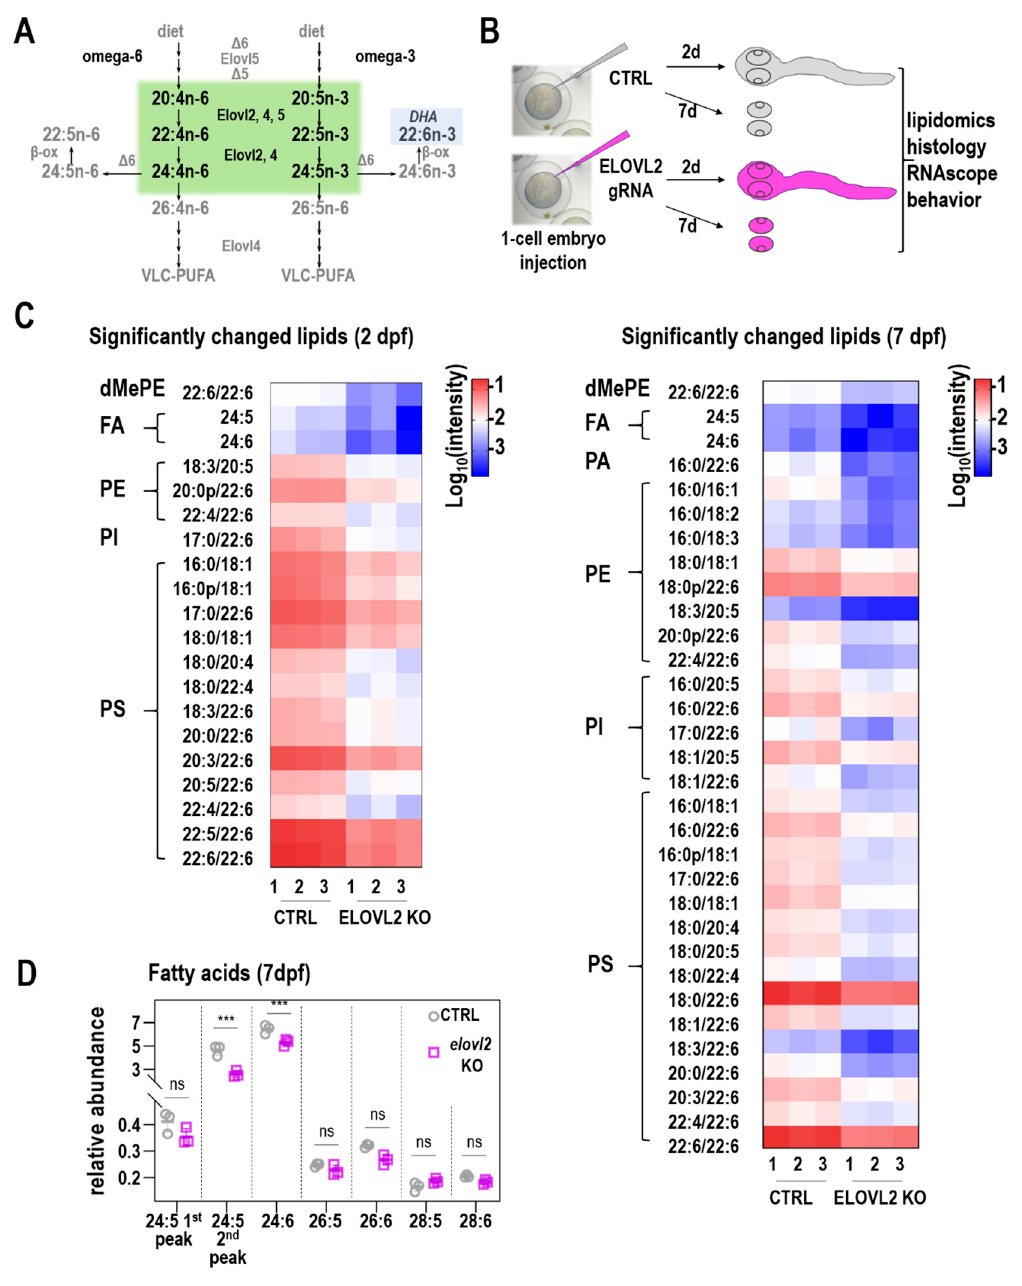
Figure 2. Generation and analysis of elovl2 crispants. ( A ) ω -3 and ω -6 PUFA elongation pathway. ( B ) Workflow for creating biallelic elovl2 mutants (‘crispants’) in zebrafish using CRISPR / Cas. ( C ) Significantly changed lipids in elovl2 crispants at days 2 and 7. In particular, all lipids containing DHA are significantly less abundant in elovl2 crispants at both days 2 and 7. ( D ) Relative abundance of PUFAs in control and elovl2 crispants shows lower abundance of products and elongated products of Elovl2. *** p < 0.005; ns—not